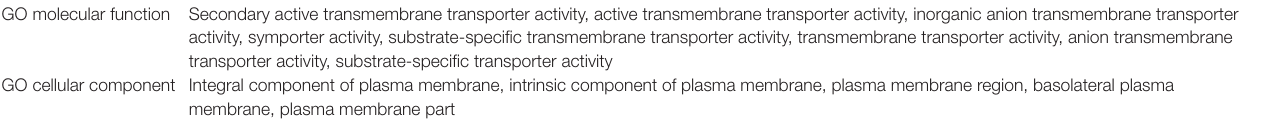
membrane, plasma membrane